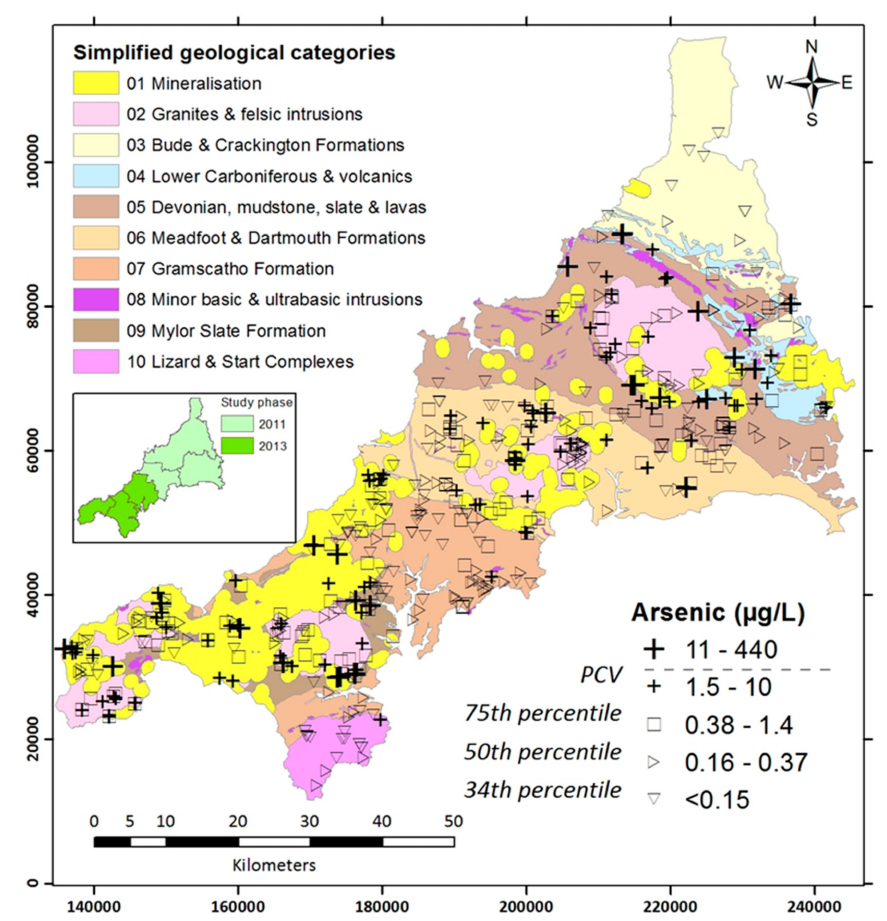
Figure 1. Map of Cornwall showing Simplified Bedrock Geological Classifications (SBGC), location and levels of arsenic measured in Private Water Supplies (PWS) tested. Geological data reproduced with the permission of the British Geological Survey © Natural Environment Research Council